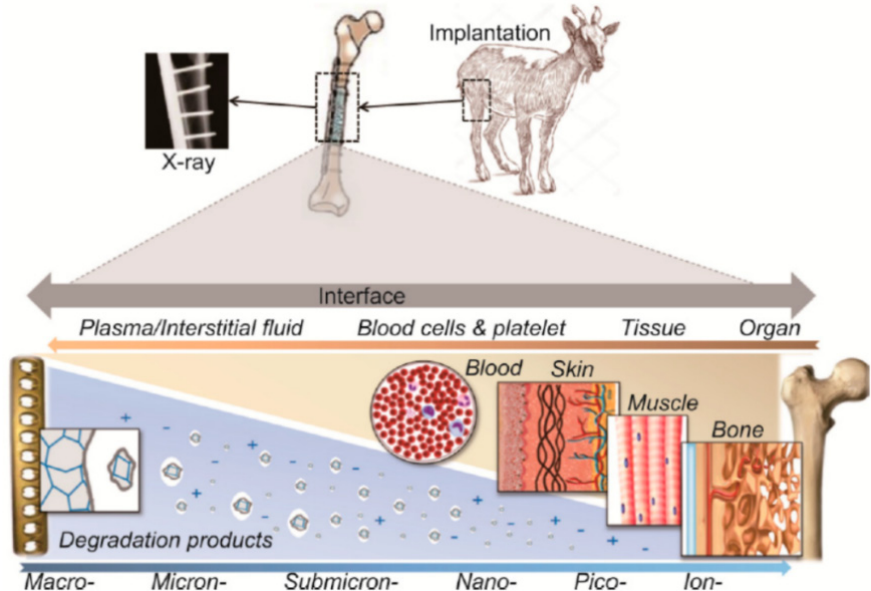
Figure 3. Illustration of biodegradable metal interacting with the local tissue, followed by the body’s response [4].